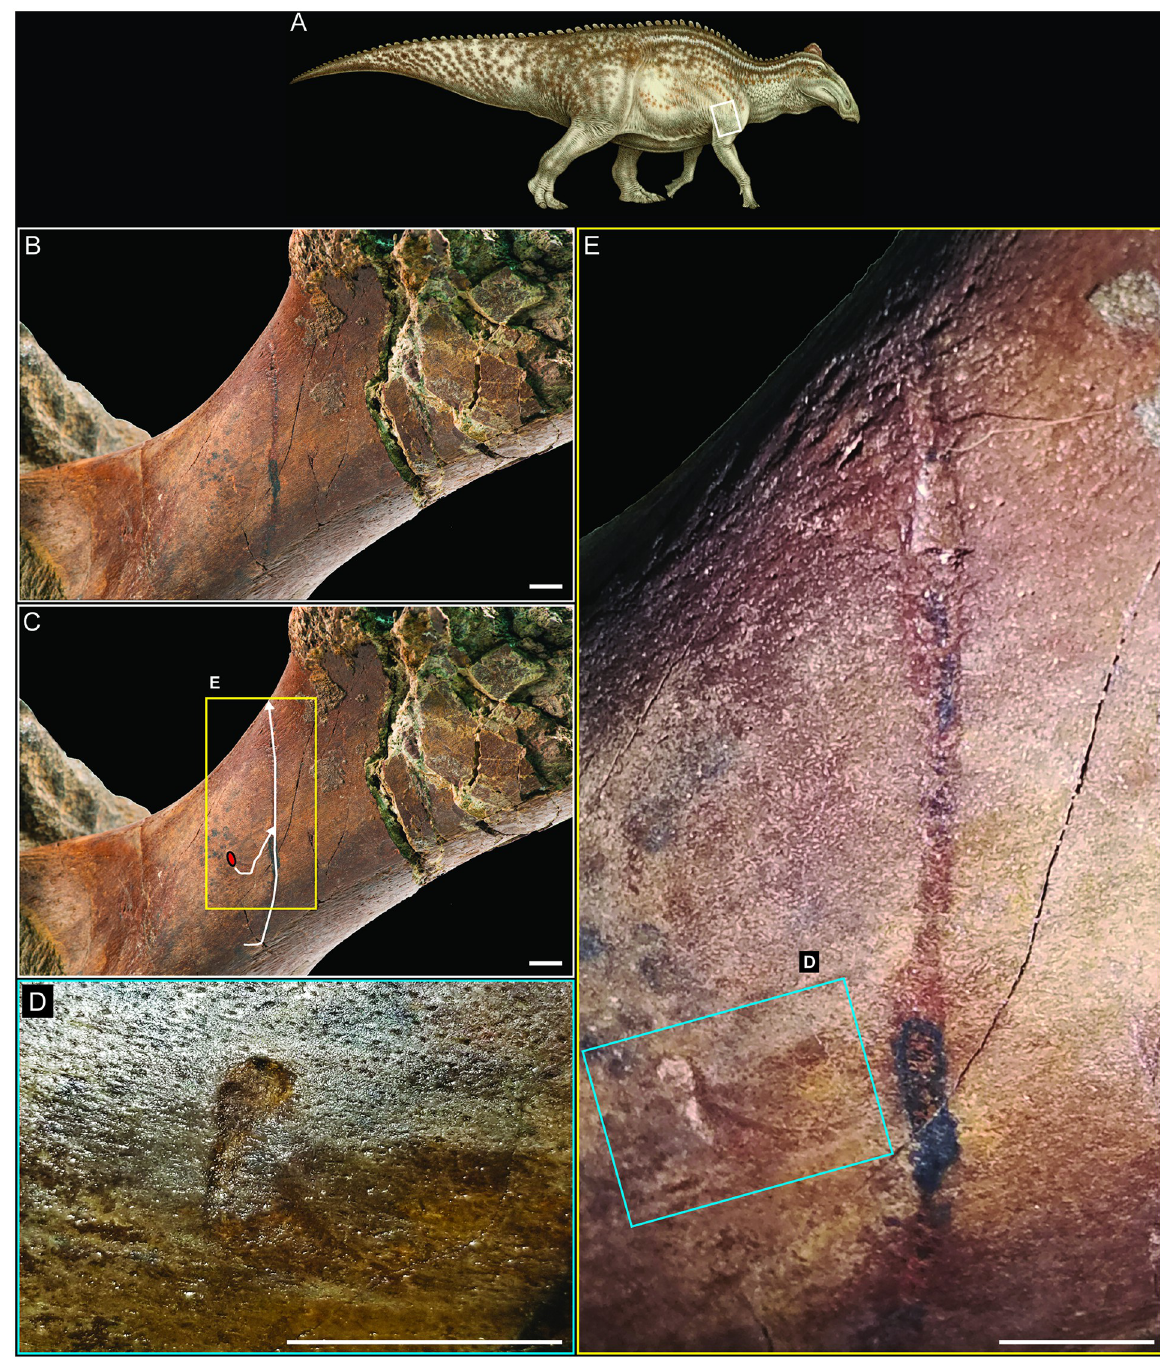
Fig 6. Additional evidence of bone surface modifications in NDGS 2000. (A) NDGS 2000 reconstruction in right lateral view. (B) Right humerus in anterior view denoting the serial hook scores (unmodified image). (C) Right humerus in anterior view showing serial hook scores with red ellipse highlighting the bisected bit and white arrows tracing the hook scores and indicated direction of the tooth across the bone. (D) Close up of bisected pit on the right humerus. (E) Close up of best preserved hook score on the right humerus. All scale bars equal 1 cm.